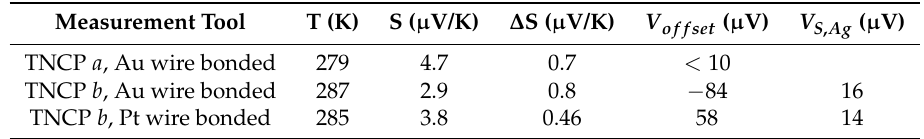
Table 1. Ag nanowire Seebeck coefficient realized using different measurement platforms, wire bonded by Au and Pt